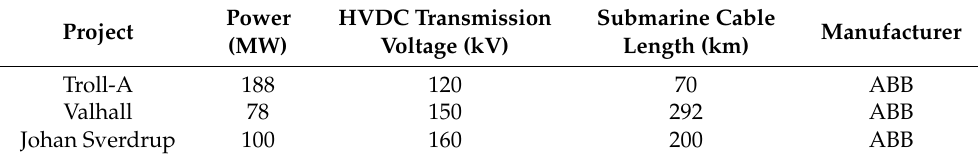
Submarine Cable Manufacturer Length (km)